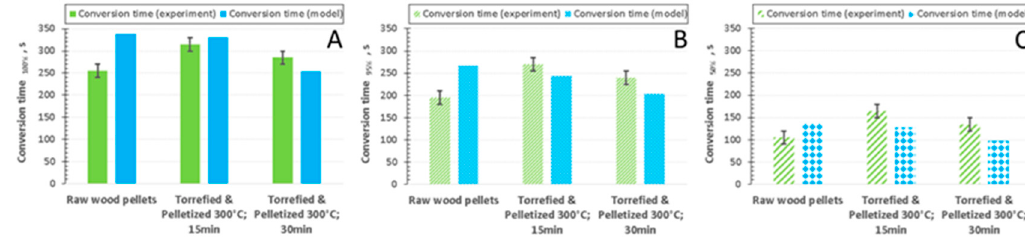
Figure 4. Conversion times for pyrolysis of pellets of raw and torrefied wood at 600 ° C, comparison of experiment and model: ( a ) conversion time for α = 1.0; ( b ) conversion time for α = 0.95; ( c ) conversion time for α = 0.5.